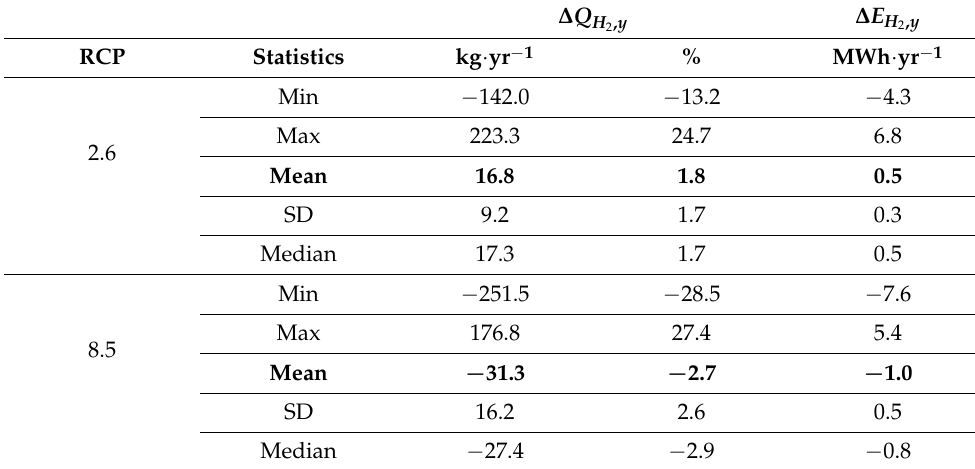
Table 6. Climate change tendencies 2005–2100 (statistical parameters for Europe).